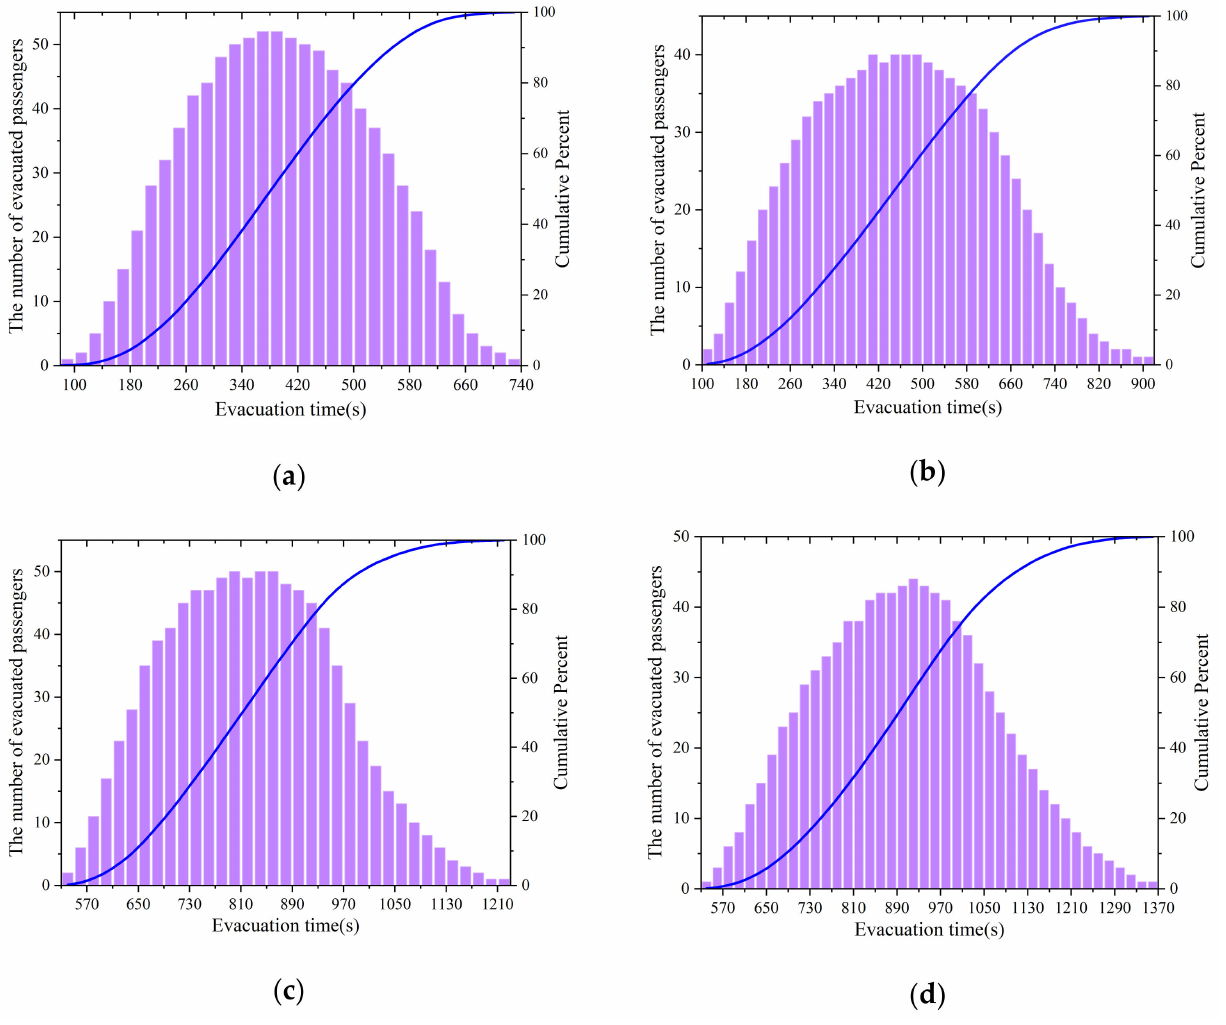
Figure 11. The arrival time distributions of passenger evacuation. ( a ) The day-individual scenario; ( b ) the day-group scenario; ( c ) the night-individual scenario; ( d ) the night-group